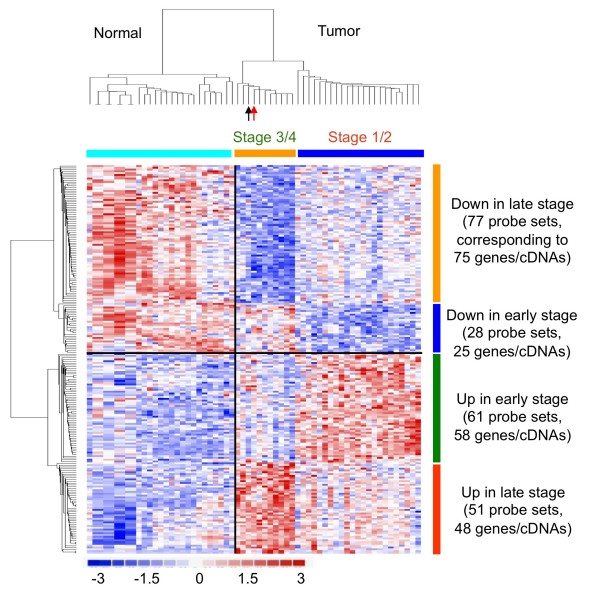
Molecular fingerprint of EEC subtypes. A heat map shows the 217 probes sets differentiating early and late EECs in the training data set, as well as discriminating normal endometrium and tumor tissues. Columns represent tumor samples; rows represent probe sets. In red, increased; in blue, decreased. Arrows indicates two early EECs which express a late EEC gene signature (black, Stage 1B; red, Stage 2B).